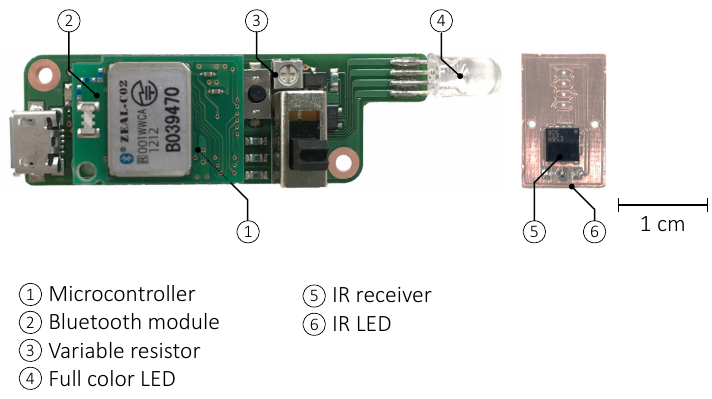
Figure 6. A control module consisting of a microcontroller, a Bluetooth module, a variable resistor, and a full-color LED and an IR communication module consisting of an IR receiver and an IR